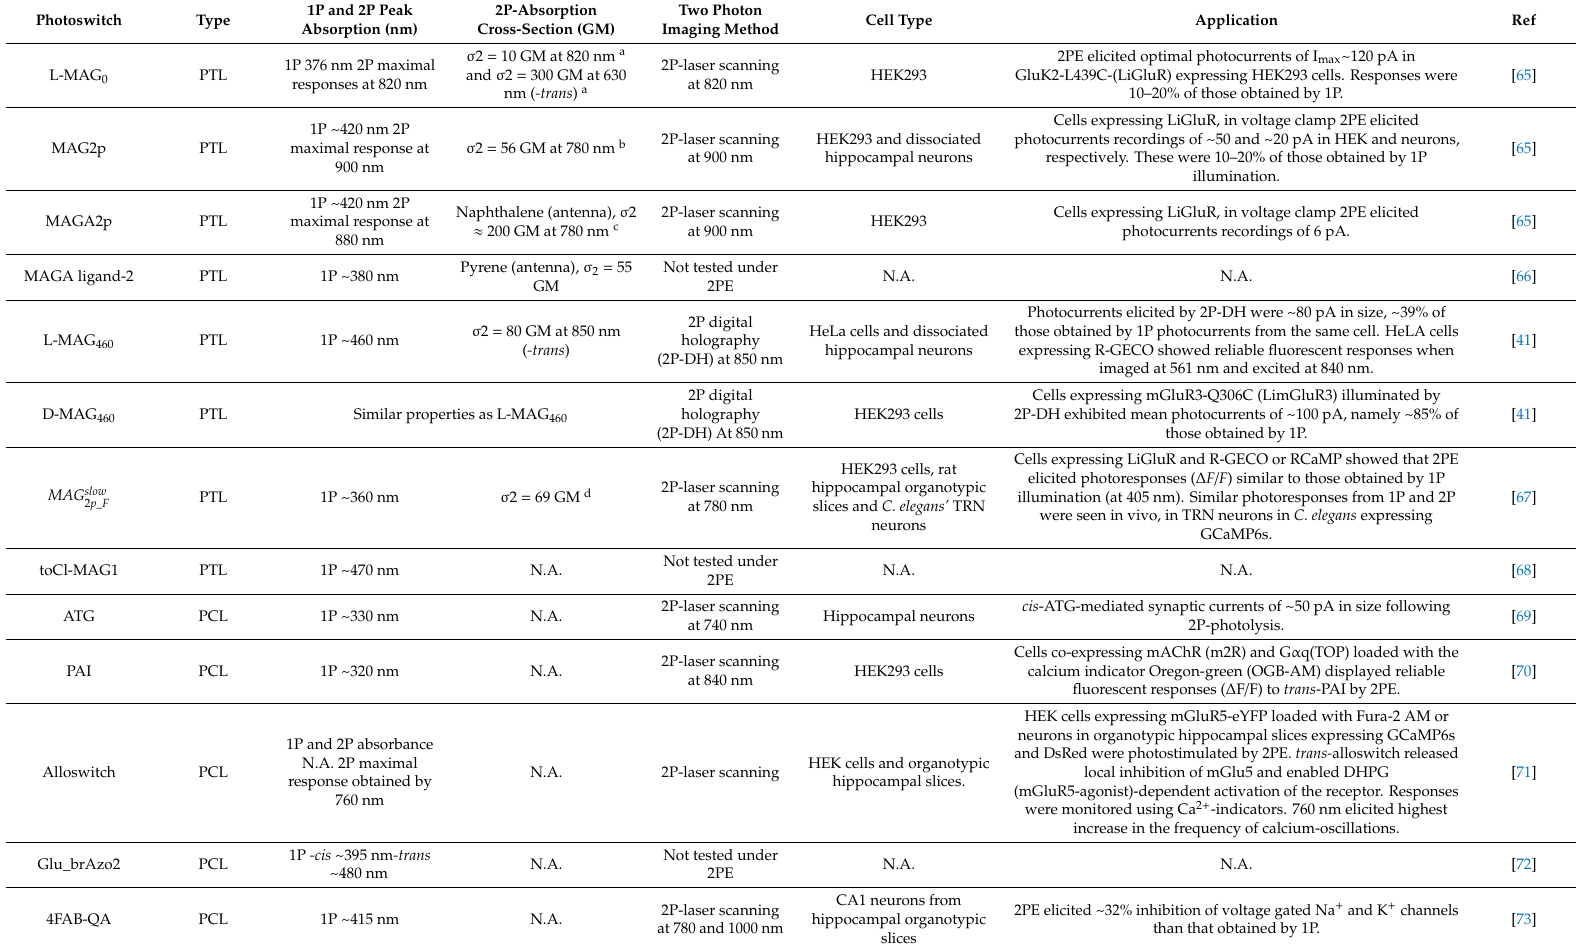
Table 1. Applications of 2PE for synthetic